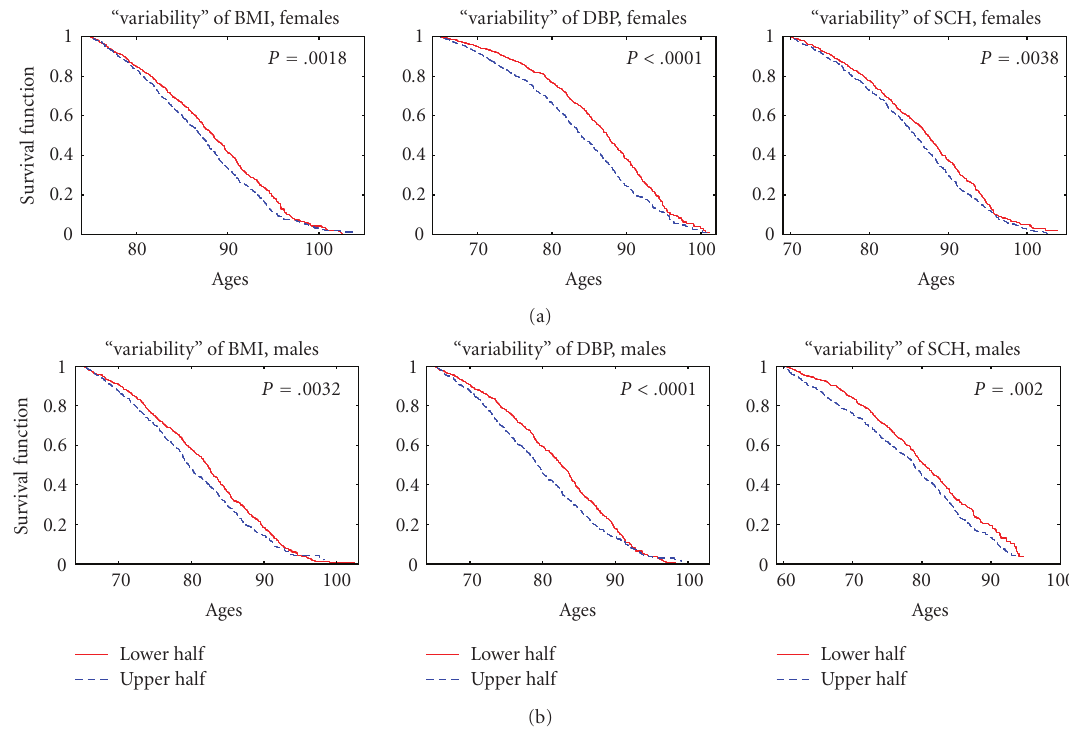
Figure 4: Kaplan-Meier estimates of survival functions for females (a) and males (b) having “variability” of di ff erent physiological indices (the mean of absolute values of residuals, i.e., deviations of observed values of an index from those approximated by two linear functions at respective age intervals, see Section 2) from the lower and upper halves of empirical distributions of this risk factor for respective indices; P denotes P value for the null hypotheses about the equality of the survival curves in the strata evaluated by the log-rank